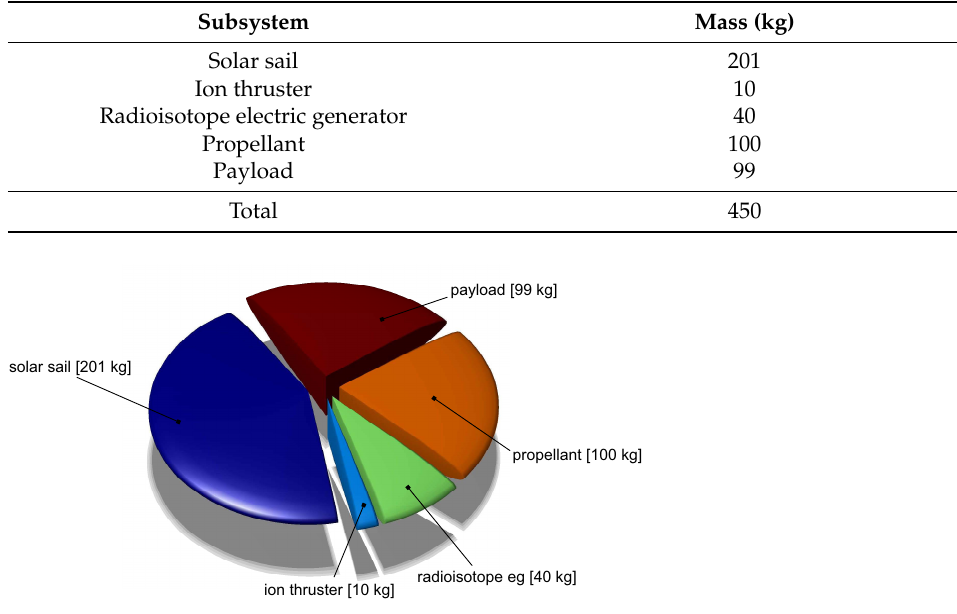
Figure 3. Mass breakdown model for Hesperides spacecraft